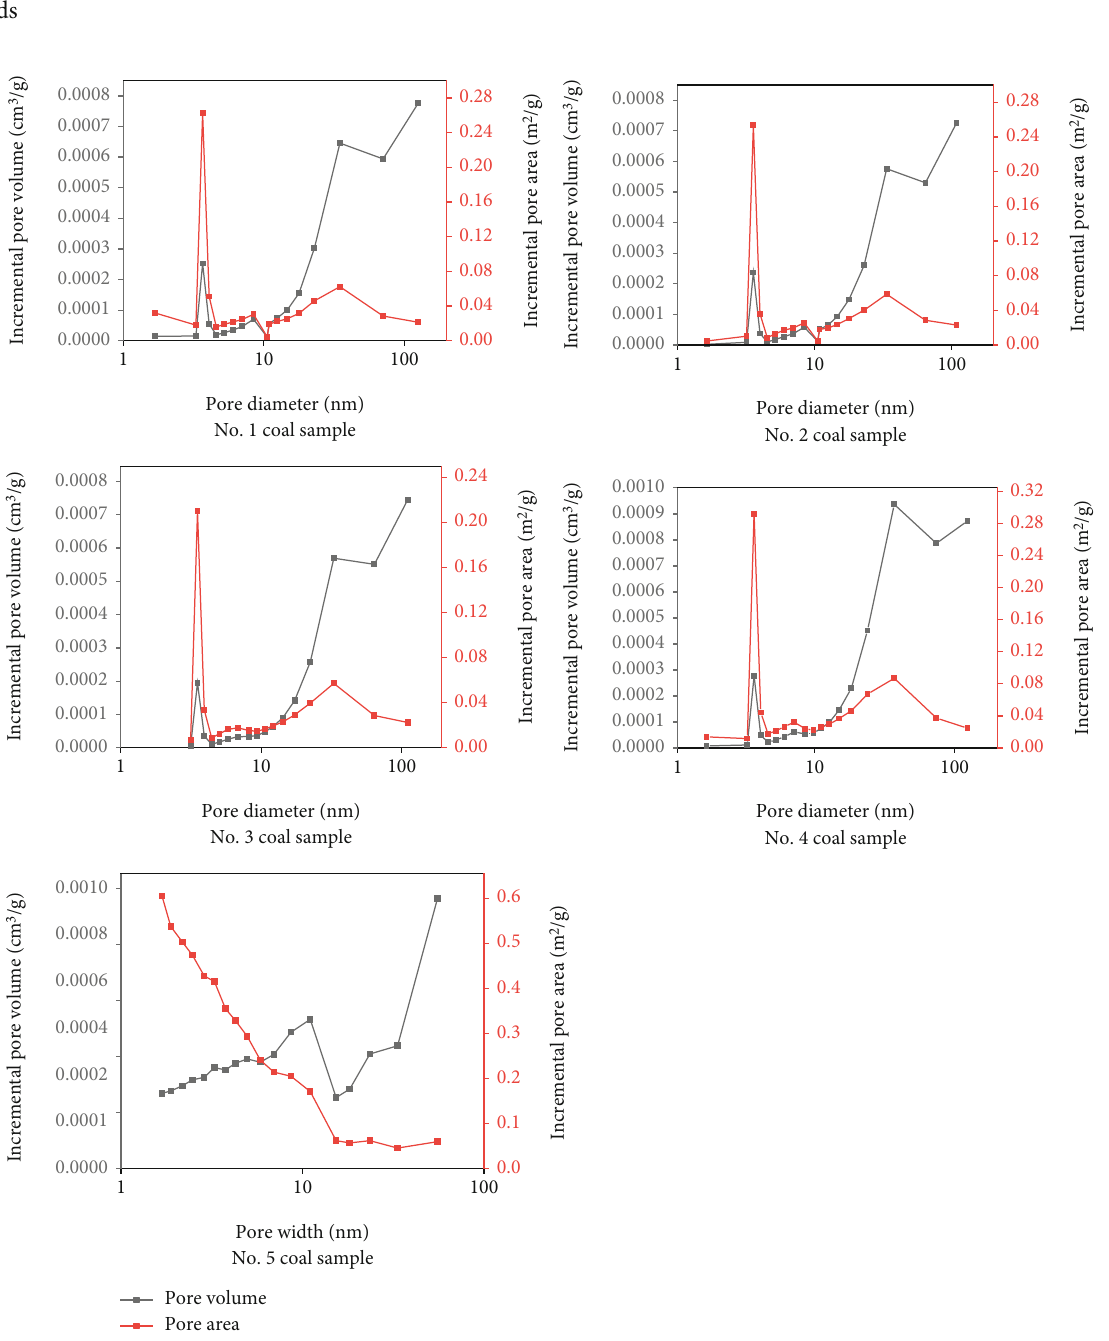
Figure 7: Increment diagram of speci fi c surface area and pore volume of coal